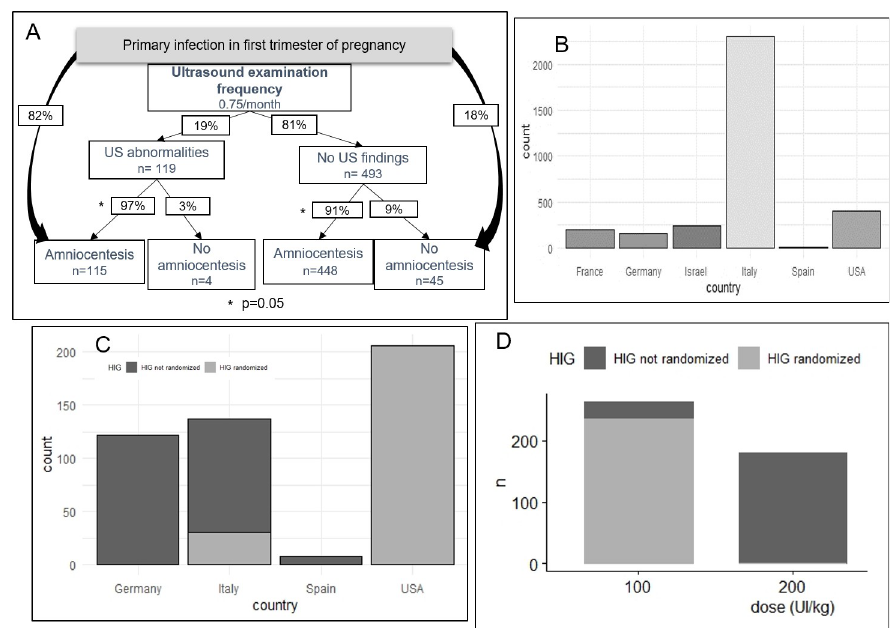
Fig 3. Management for population 1. Population 1 flowchart with radiological interventions. Amniocentesis is described according to US abnormalities or not. Patients receiving HIG in RCT are colored in middle grey and patients receiving HIG in observational studies are colored in dark grey. A. Repartition of population 1 according to their country of study. B. Repartition of patients receiving HIG for preventive treatment according to their country. C. Repartition of patients receiving HIG for preventive treatment according to dose of HIG: 100 IU/kg or 200 IU/kg. US: ultrasound; HIG: hyperimmunoglobulin; RCT: randomized controlled trial.